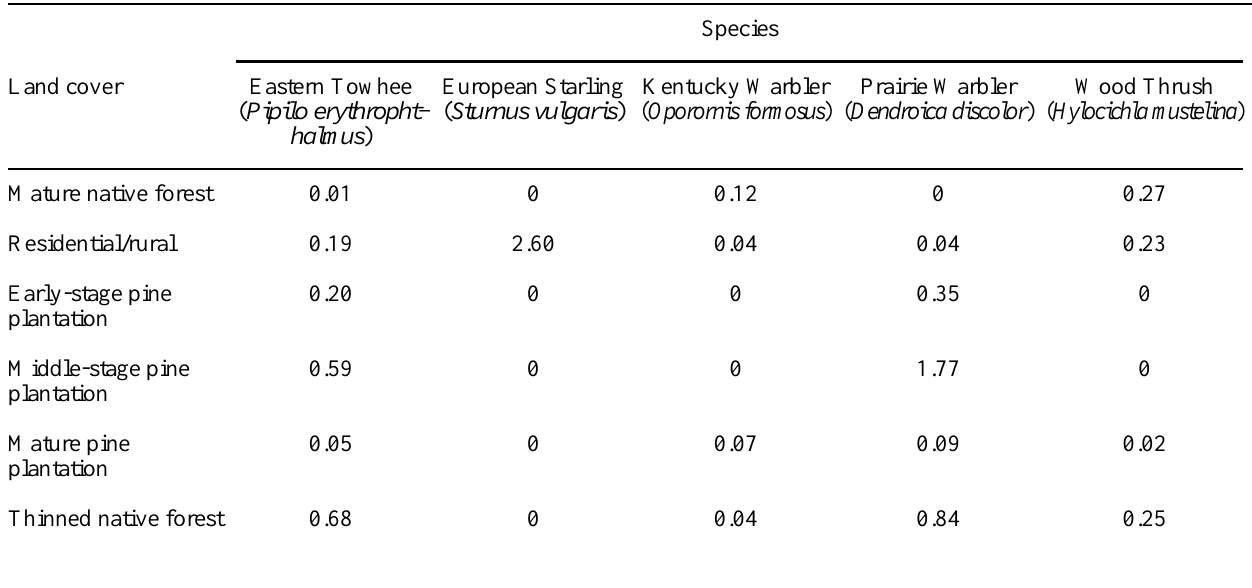
Table 3. Densities of five avian species of management interest in each land cover category used in the simulation